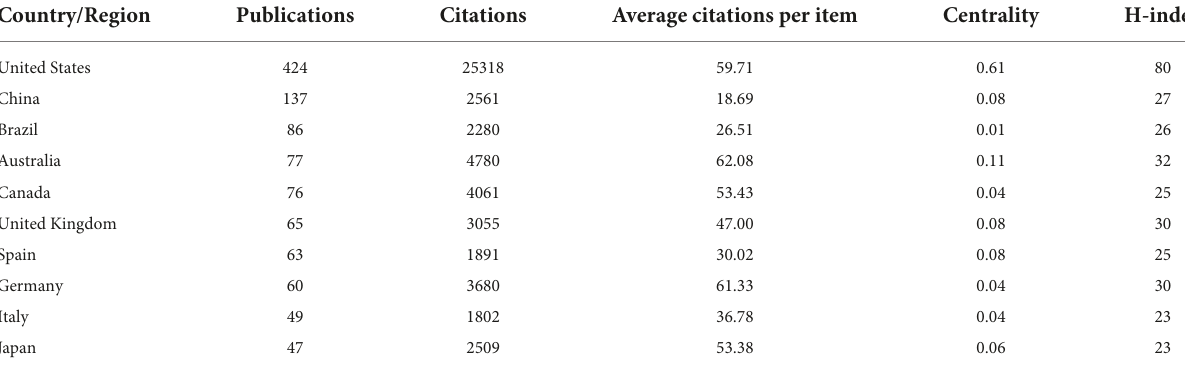
TABLE 1 Top 10 most productive countries/regions.